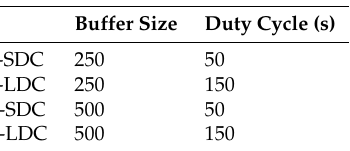
Figure 4. Bikes travel time in seconds. Table 1. Simulated cases.